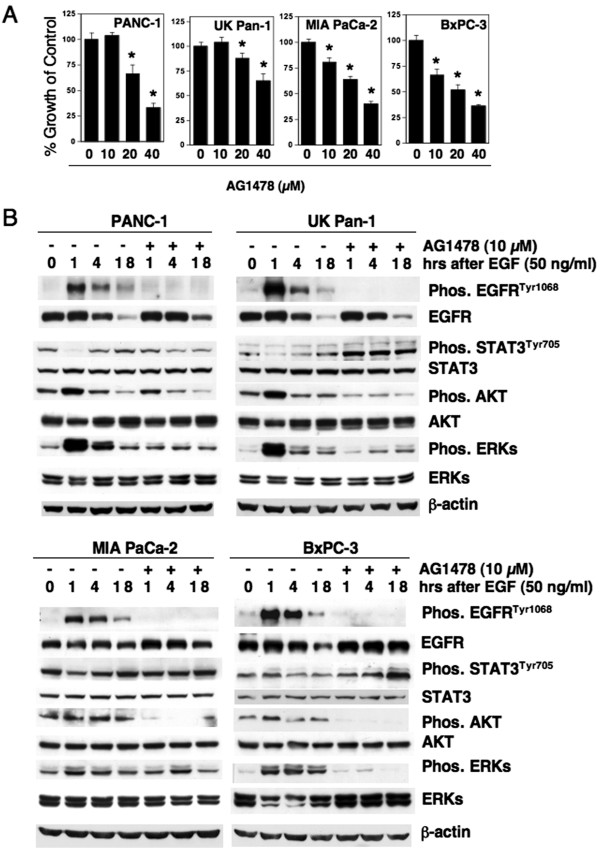
EGFR inhibitor AG1478 suppresses growth of human pancreatic cancer cells in vitro and constitutive STAT3Tyr705 phosphorylation is not suppressed by EGFR inhibitor AG1478 in PDAC cells. A, Exponentially growing PDAC cells were treated with indicated concentrations of EGFR inhibitor AG1478 for 96 h and MTT assays were performed to measure cell growth. Data are presented as % growth of control. Bars represent SD of eight replicates, and experiments repeated for three times. (*) = highly significant with a p < 0.001. B, PDAC cells were serum deprived for 48 h and pre-treated with EGFR inhibitor, AG1478 (10 μM) for 4 h followed by stimulation with EGF (50 ng/mL) for indicated periods of time in the presence or absence of EGFR inhibitor. Vehicle DMSO was used where EGFR inhibitor was not used. Equal amounts of proteins were loaded and the blots were probed for phosphorylated and total forms of EGFR, STAT3, AKT and ERKs. As a loading control, human β-actin levels are shown.